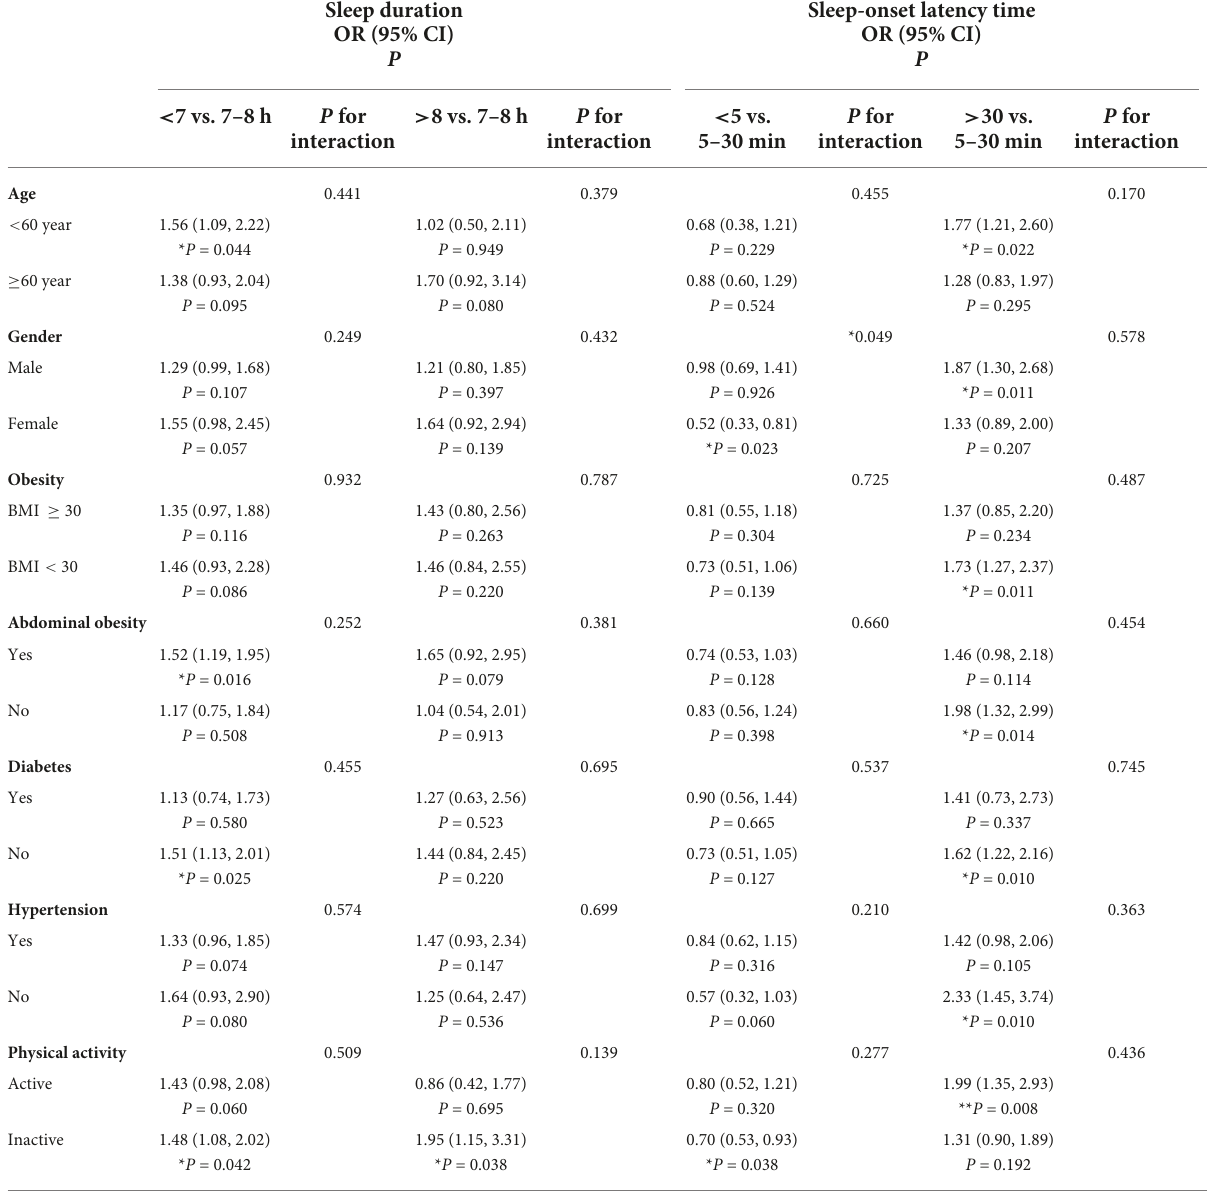
TABLE 4 Subgroup analysis of the associations of sleep duration and sleep-onset latency time with total